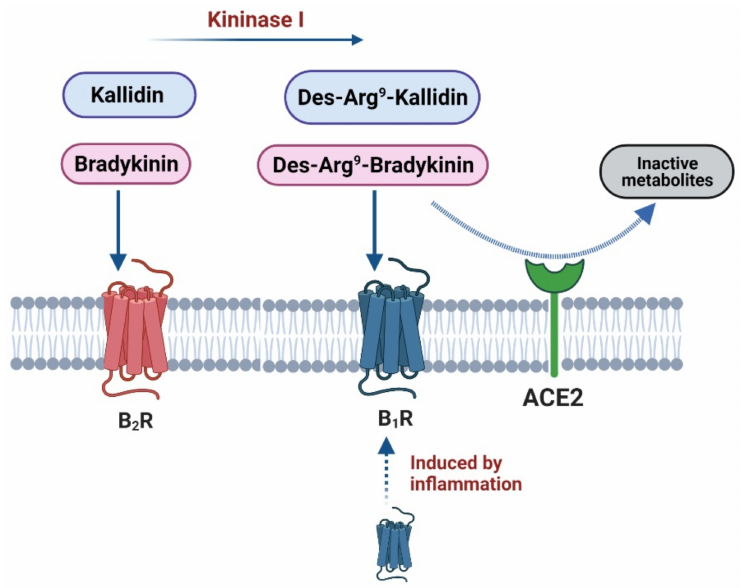
Figure 4. Receptor stimulation of B 1 and B 2 receptors. Kallidin (KD) and Bradykinin (BK) act principally on B 2 receptors, while Des-Arg 9 -Kallidin and Des-Arg 9 -Bradykinin act on B 1 receptors. As shown in the figure, the B 1 receptor is induced by inflammation. ACE2 plays a role in the degradation of Des-Arg 9 -Kallidin and Des-Arg 9 -Bradykinin (created with